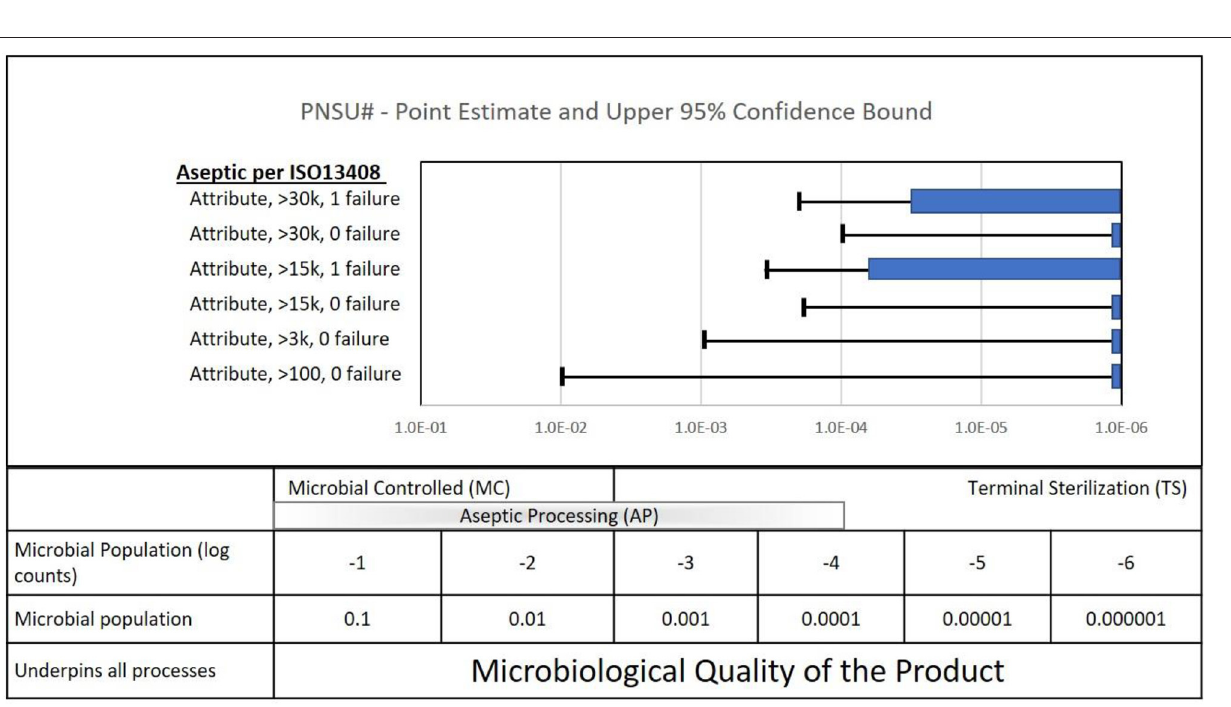
FIGURE 7 | Quantifiable aspects of the sample sizes called out in the ISO standard for aseptic processing (ISO 13408-1).